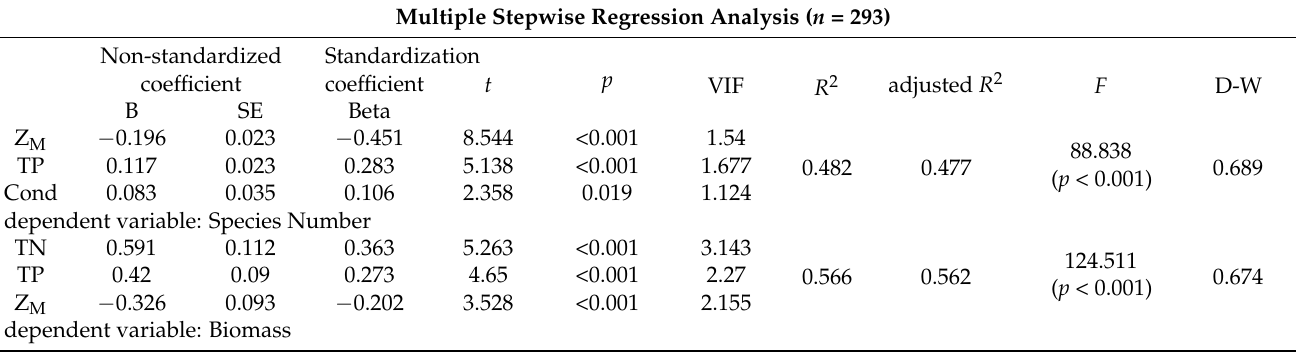
Table 2. Results of multiple stepwise regression analysis of phytoplankton and environmental parameters in the eight studied lakes.